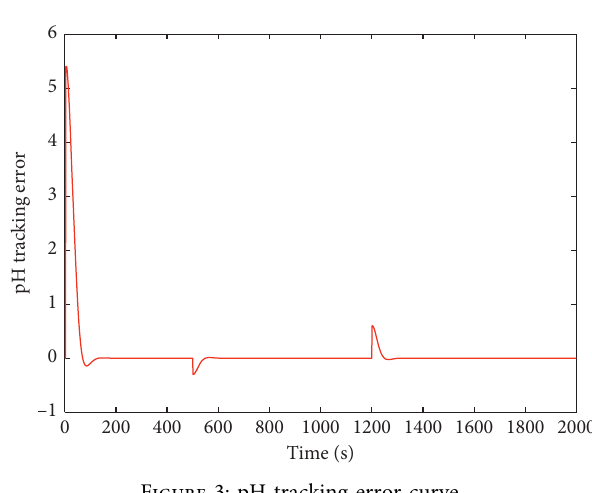
Figure 3: pH tracking error curve.